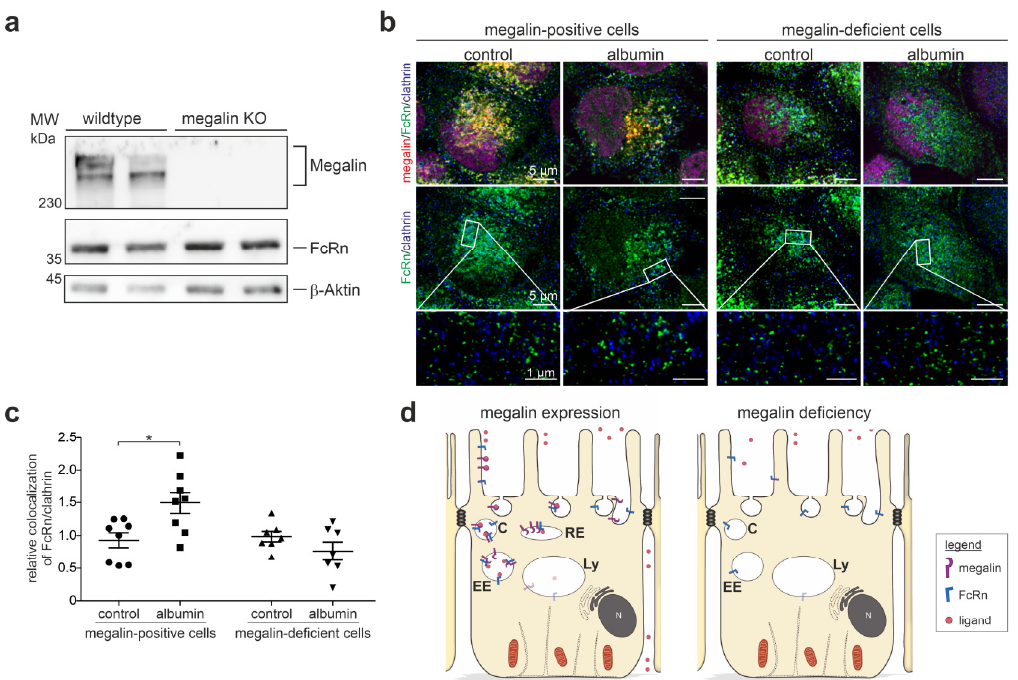
Figure 4. Megalin deficiency prevents FcRn trafficking . ( a ) Western blot of megalin and FcRn on wildtype and megalin-deficient cells by CRISPR/Cas9. Successful deletion of megalin is confirmed, the abundance of FcRn remains unaltered. Beta-actin is used as house keeping control. ( b ) Quadruple staining of FcRn, megalin, and clathrin for clathrin vesicles, at baseline (control) or induction of endocytosis by albumin. Nuclei are stained with DAPI. Higher resolution STED images of inset are shown below for each respec- tive image. Magnification scale bar = 5 µm and 1 µm as indicated. ( c ) Relative changes in colocalization of FcRn and clathrin upon endocytosis induction by albumin using Pearson correlation coefficient. In this study, >150 cells of n = 7–8 independent experiments, student’s t-test, * p < 0.05 was considered significant. ( d ) Summarizing cartoon showing wildtype (megalin-positive) cells upon albumin-induced endocytosis